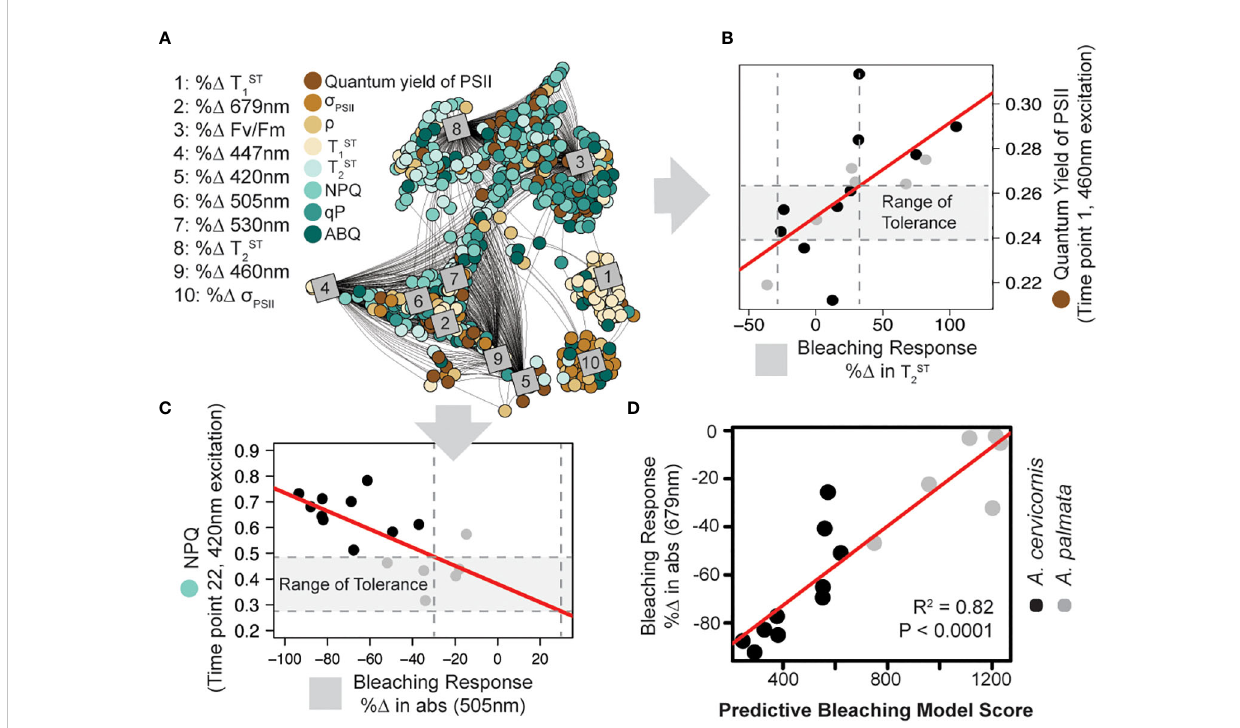
FIGURE 4 Model training and predictive bleaching output. Network analysis (A) reveals strong correlations between speci fi c algal biometrics (circles; measured by our novel instrument and protocol) with coral bleaching response metrics (squares; measured as % change in response to high temperature). Connecting lines re fl ect signi fi cant correlation (Pearson > 0.5). Representative correlations pulled from the analysis show a strong relationship between the quantum yield of PSII ( F 460 PSII ) and the % D in Tau 2 (B) or light energy dissipation (NPQ 420 ) and the % D in absorbance at 505nm (C) . A range of tolerance is then constructed for each algal photo-physiological-bleaching response metric combination identi fi ed in the network analysis. Vertical dashed lines outline a ± 30% change in response to thermal stress while horizontal dashed lines outline the range of tolerance (gray outline). The resulting model was then tested against the training data by ranking each coral genotype based on the number of photo-physiological metrics that fall within their corresponding range of tolerance (higher model numbers suggest greater thermal tolerance). (D) The accuracy of the predictive bleaching model was compared to a coral bleaching proxy (% D in absorbance at 679nm) and the strength of the correlation was tested using linear regression (red